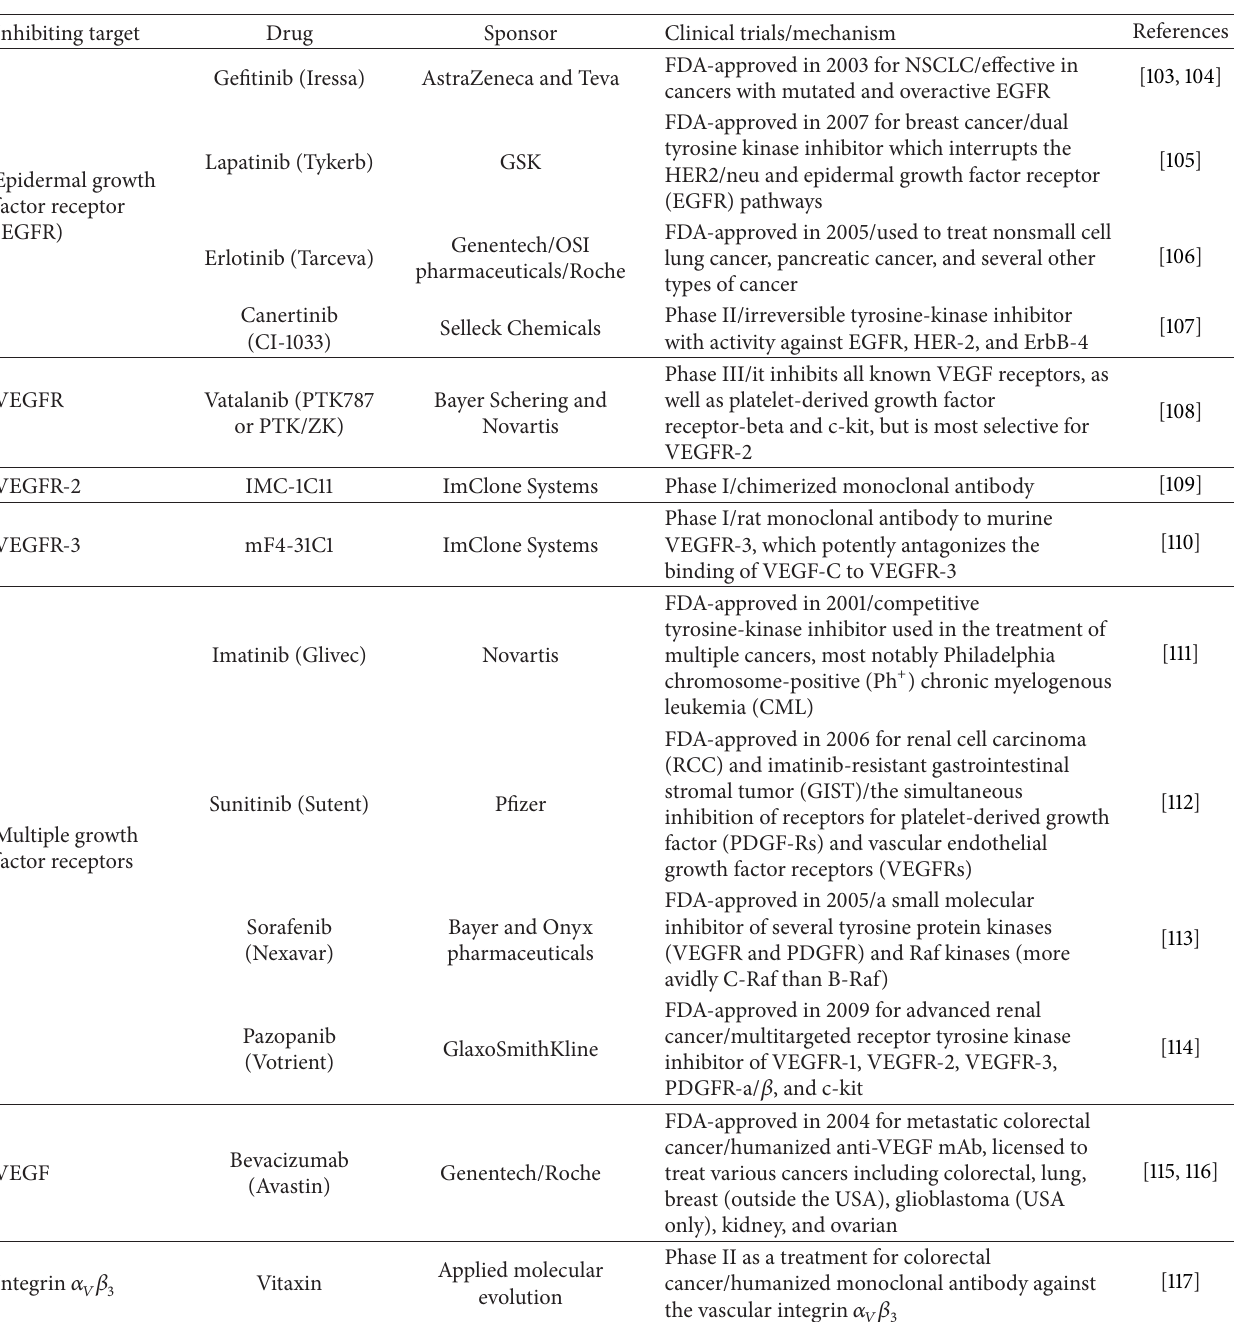
Table 4: Selected angiogenesis inhibitors in clinical